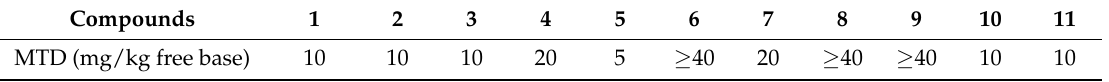
Table 4. Maximum tolerated dose (MTD) of HDP mimetics in female Swiss CD.1 mice.